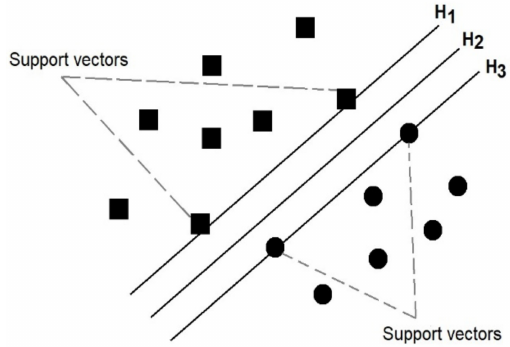
Figure 1. Illustration of the main SVM principle for a linear problem (modified) [73].